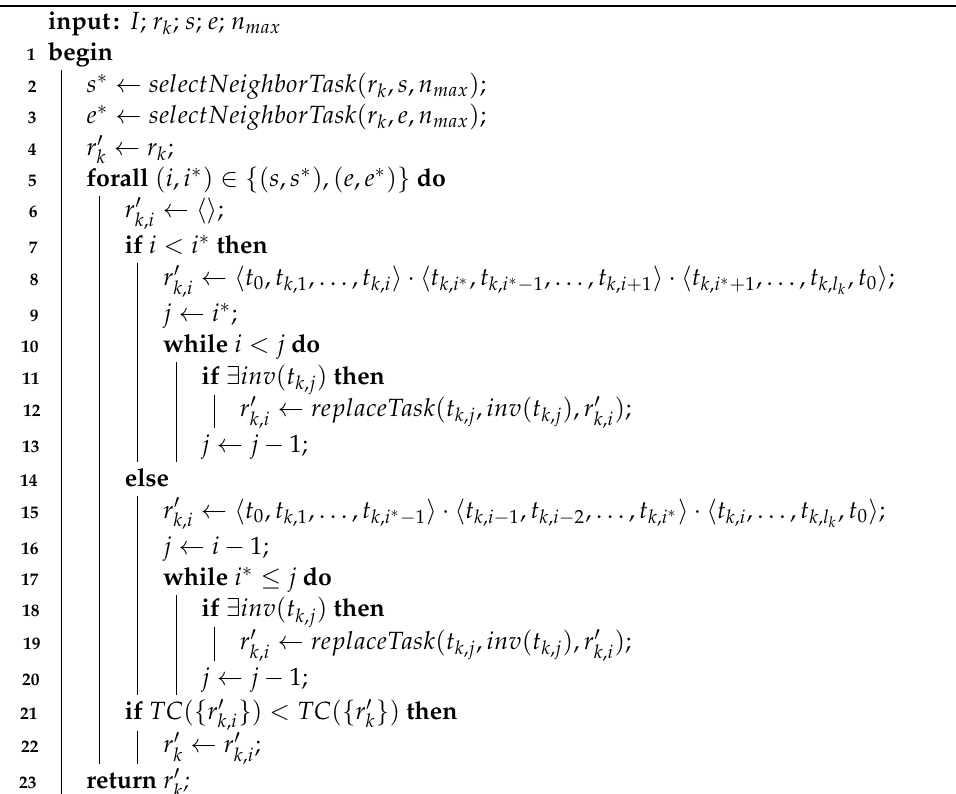
Algorithm 9: subRoutePlanRotation (algorithm of the sub-route plan rotation method within the sub-route plan